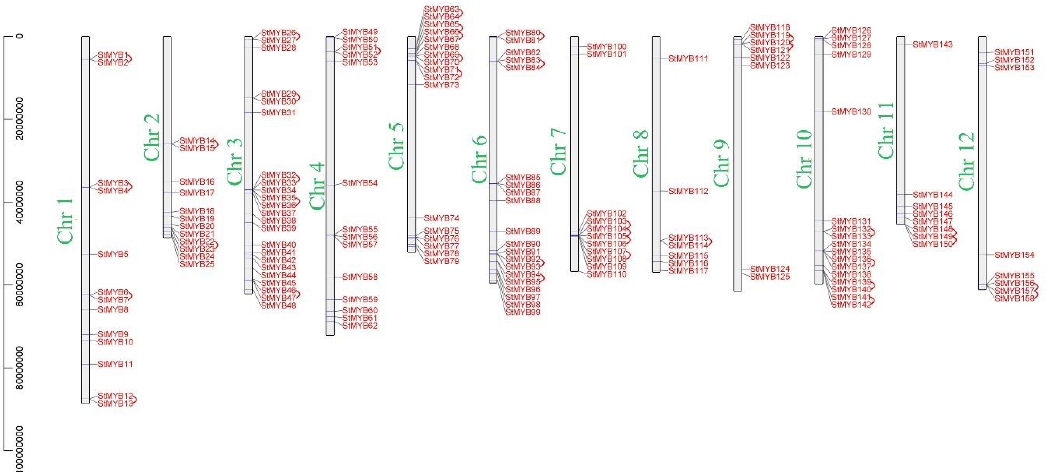
Figure 3. The distribution of MYB genes on chromosomes. The chromosome number is indicated to the left of each chromosome.